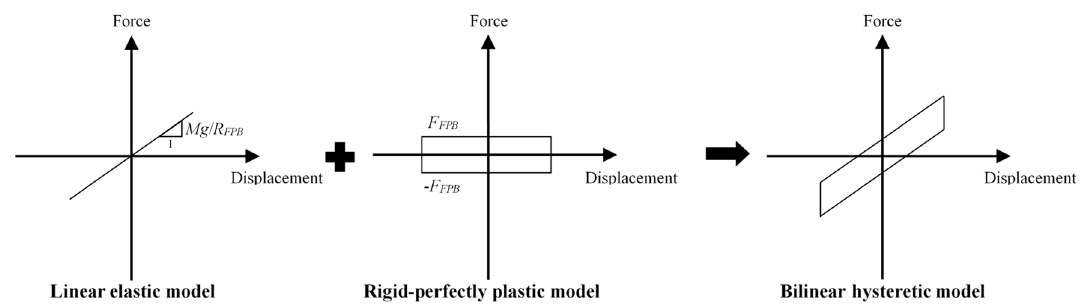
Figure 9. Idealized composition of analytical models for FPBs.